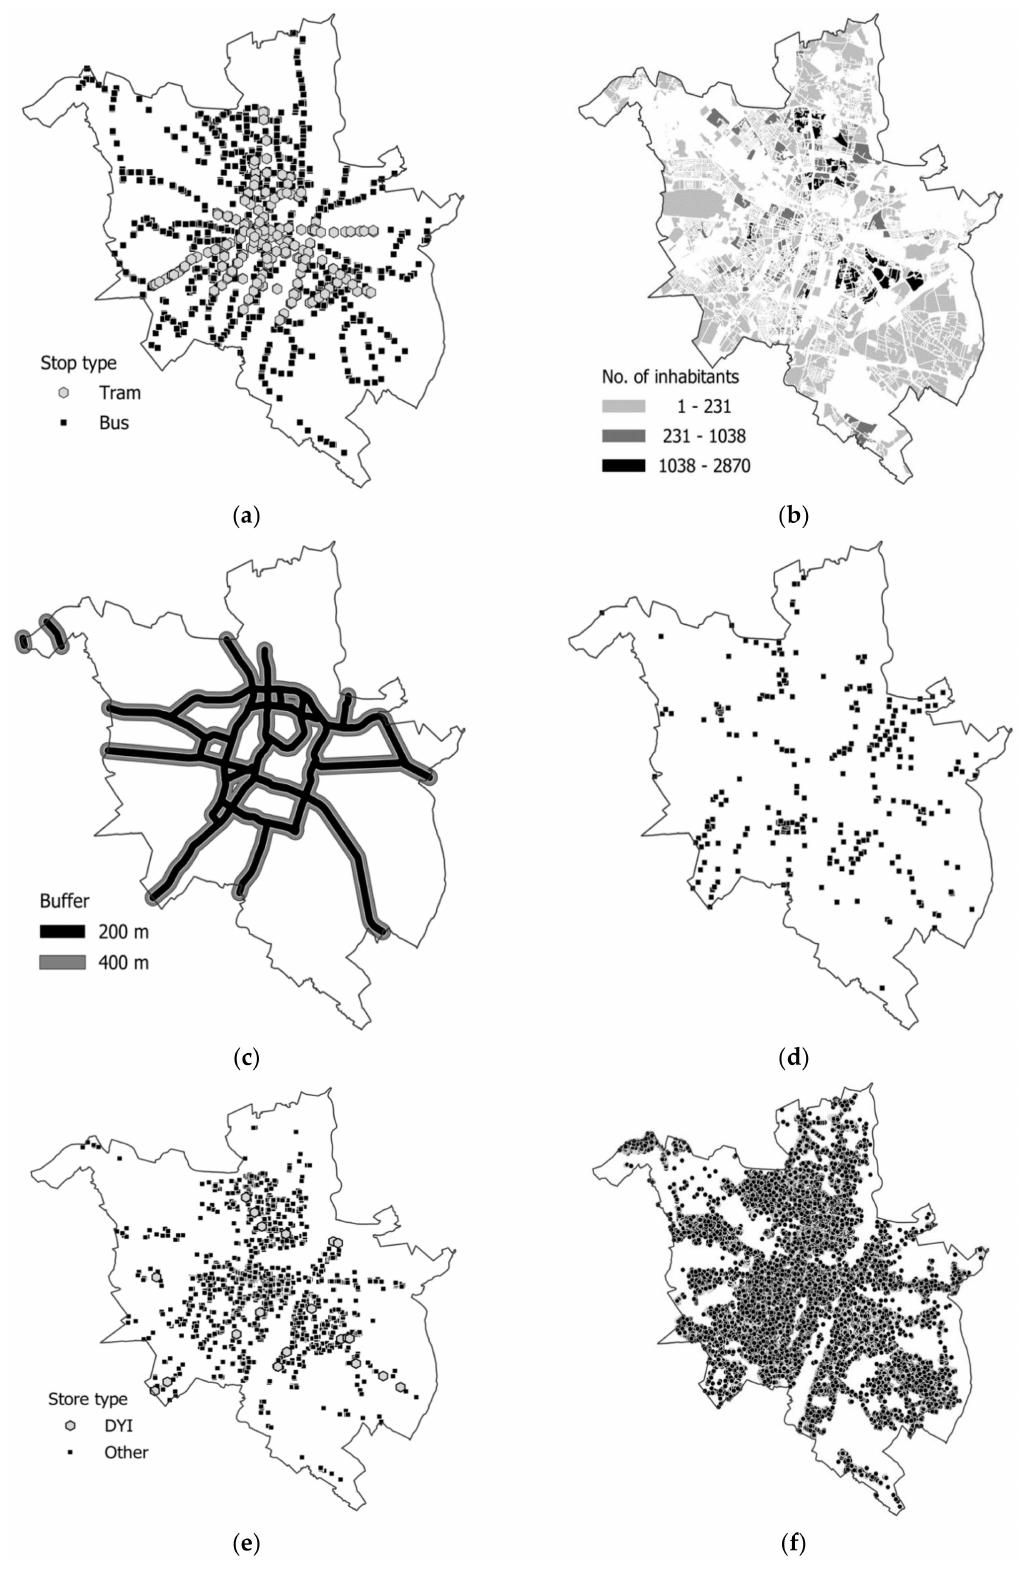
Figure 4. Data utilized during the computation of value of each criterion: ( a ) C1—tram and bus stop locations; ( b ) C2—city blocks inhabited by at least one working-age person; ( c ) C3—primary road system in Poznan, with 200 and 400 m buffers; ( d ) C4—centroids of industrial areas; ( e ) C6 and C8—store locations, including DYI stores; ( f ) C7—address point